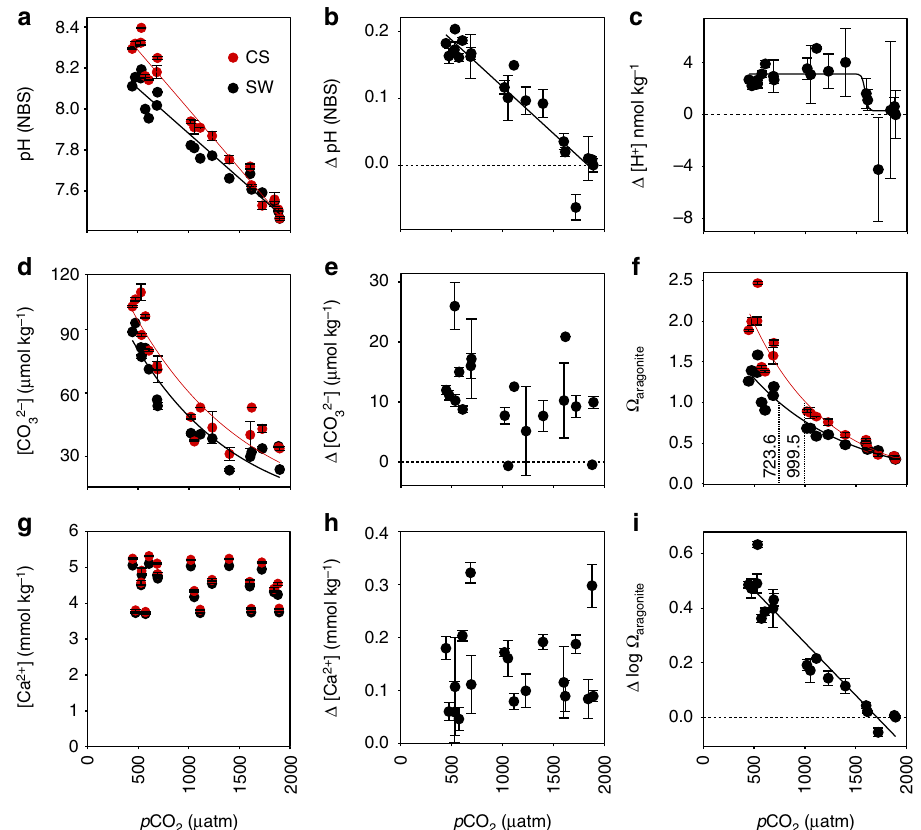
Fig. 4 Impact of OA, in black on carbonate chemistry parameters at the site of calci fi cation in red from Exp 3. a pH NBS b Δ pH NBS (CS-SW) c Δ [H + ] d [CO 3 2 − ] e Δ [CO 3 2 − ] (CS-SW) f Ω arag g [Ca 2+ ] h Δ [Ca 2+ ] i Δ log Ω arag . Plotted data are the mean + s.d. from N = 4 fertilizations and 5 larvae for each treatment and